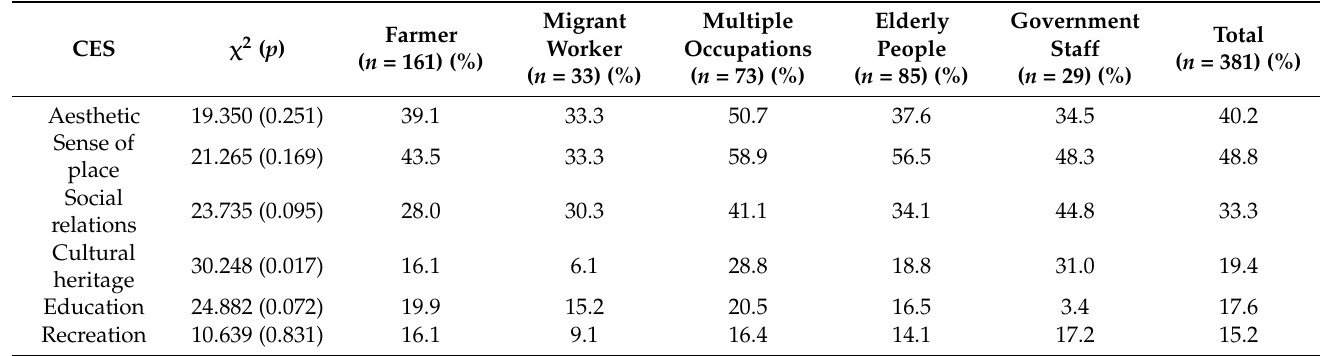
Table 4. Cultural ecosystem service demand among five different stakeholder groups in Shigou